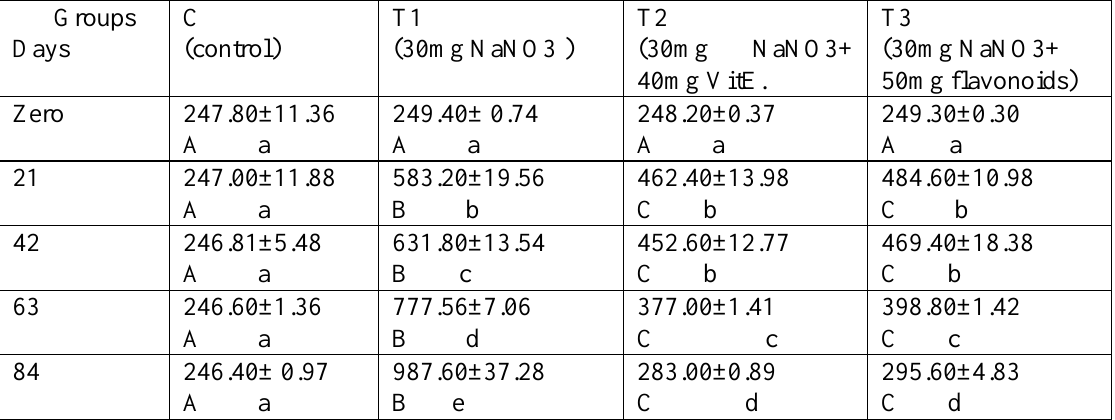
Table (3): Effect of sodium nitrate, vitamin E and flavonoids extracted from Nigella